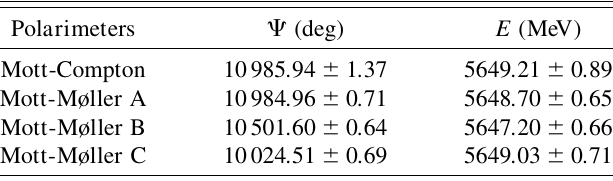
TABLE X. Final beam energies measured by total precession (cid:5) 5 : 2 (cid:6) 1 : 0 MeV . evaluated at E 12